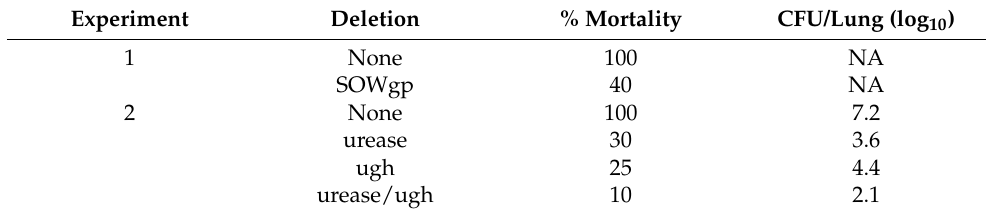
Table 1. Pathogenicity of some C. posadasii deletion mutants.